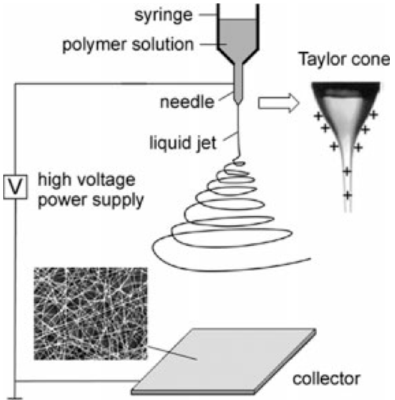
Figure 2. Schematic diagram of the basic setup for electrospinning process and Taylor cone [98] (Copyright 2004, John Wiley and Sons).